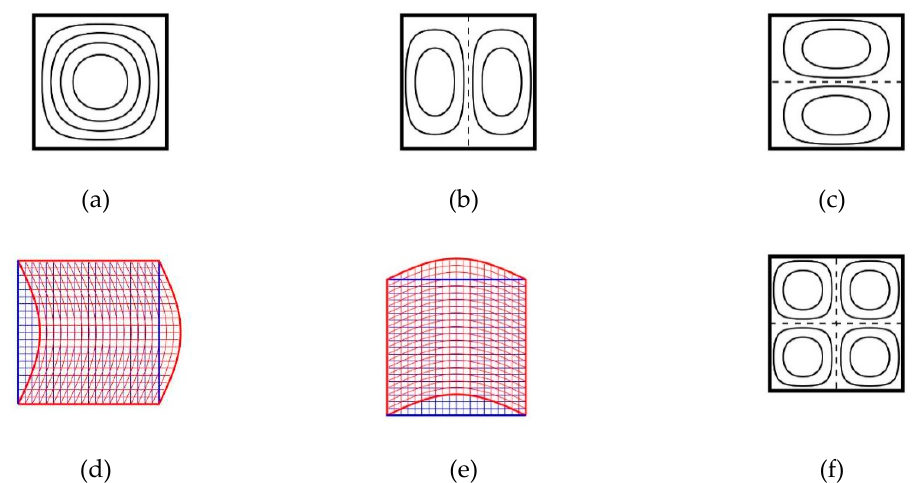
Figure 3. Mode shapes for an FGM square plate with SSSS boundary conditions: ( a ) mode 1; ( b ) mode 2; ( c ) mode 3; ( d ) mode 4; ( e ) mode 5; ( f ) mode 6.